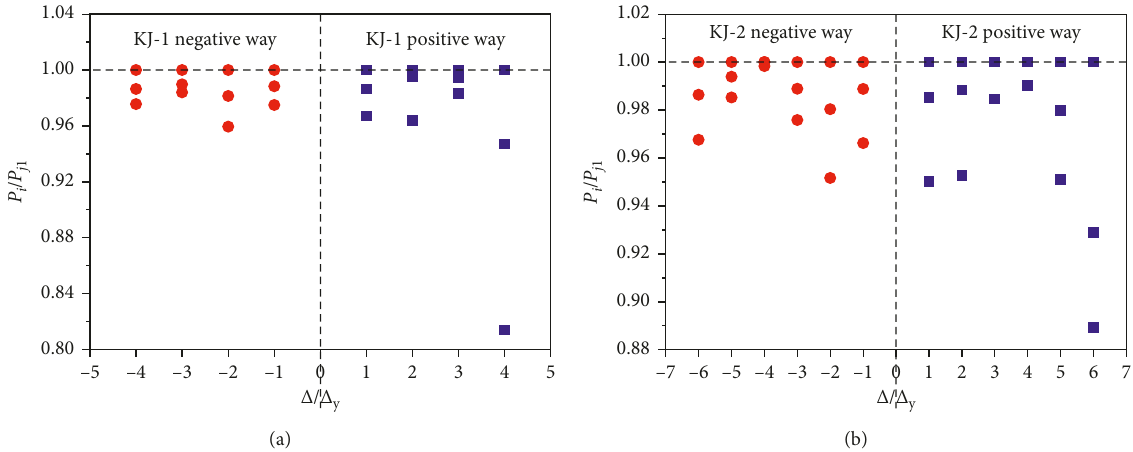
Figure 7: Strength attenuation of specimens: (a) specimen KJ-1, (b) specimen